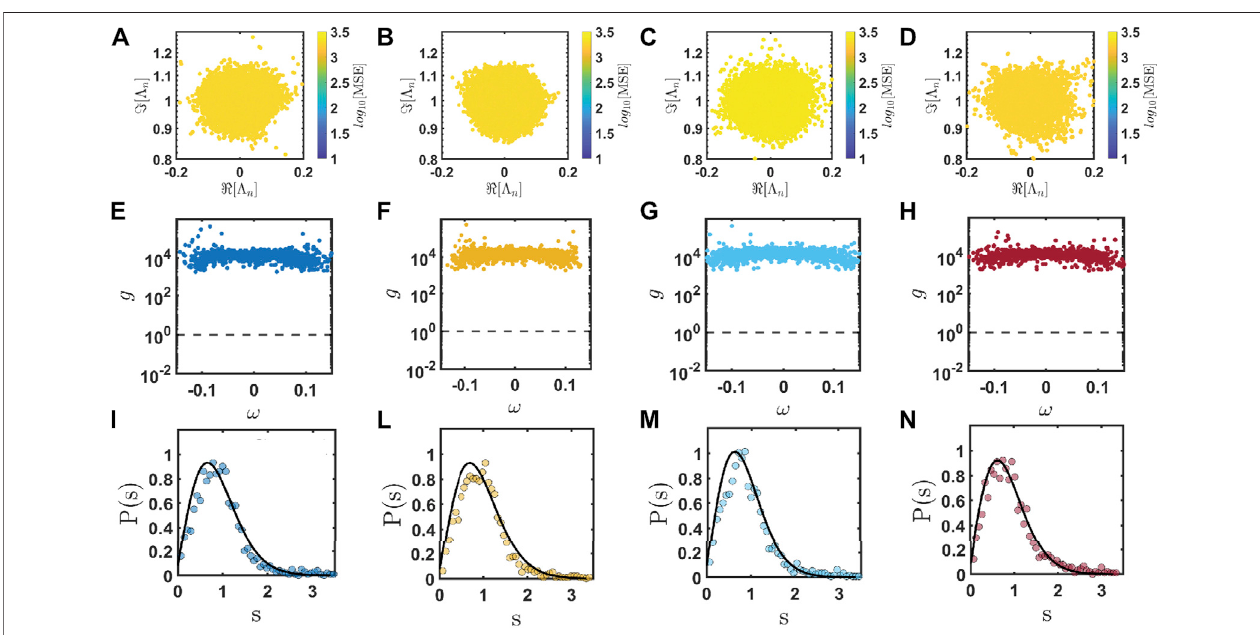
FIGURE 6 | Eigenvalues distribution of the Green ’ s matrix(13) in the low scattering regime (i.e., ρλ 2 (cid:3) 10 – 6 ) for two representative Euclidean [panels (A,B) ] and non Euclidean[panels (C,D) ]CPA.Inparticular,panels (A – D) refertothearraysgeneratedbyfollowingtheprimeelementsinthecomplexquadratic fi elds Q ( (cid:1)(cid:1)(cid:1)(cid:1) √ (cid:1)(cid:1)(cid:1)(cid:1)(cid:1) √ Q ( − 67 − 163 ),and Q ( ),respectively.TheThoulessnumber g asafunctionofthefrequency ω andthelevelspacingstatistics P ( s )extrapolatedfromthedistributionsof panels (a – d) are reported in panels (E – H) and (I – N) . These data demonstrate that the investigated arrays are in the diffusive regime: g is always larger than unity [horizontal black dashed line in panels (E – H) ] and P ( s ) is well-reproduced by the critical statistic in Eq. 17 [continuous black line in panels (I – N)